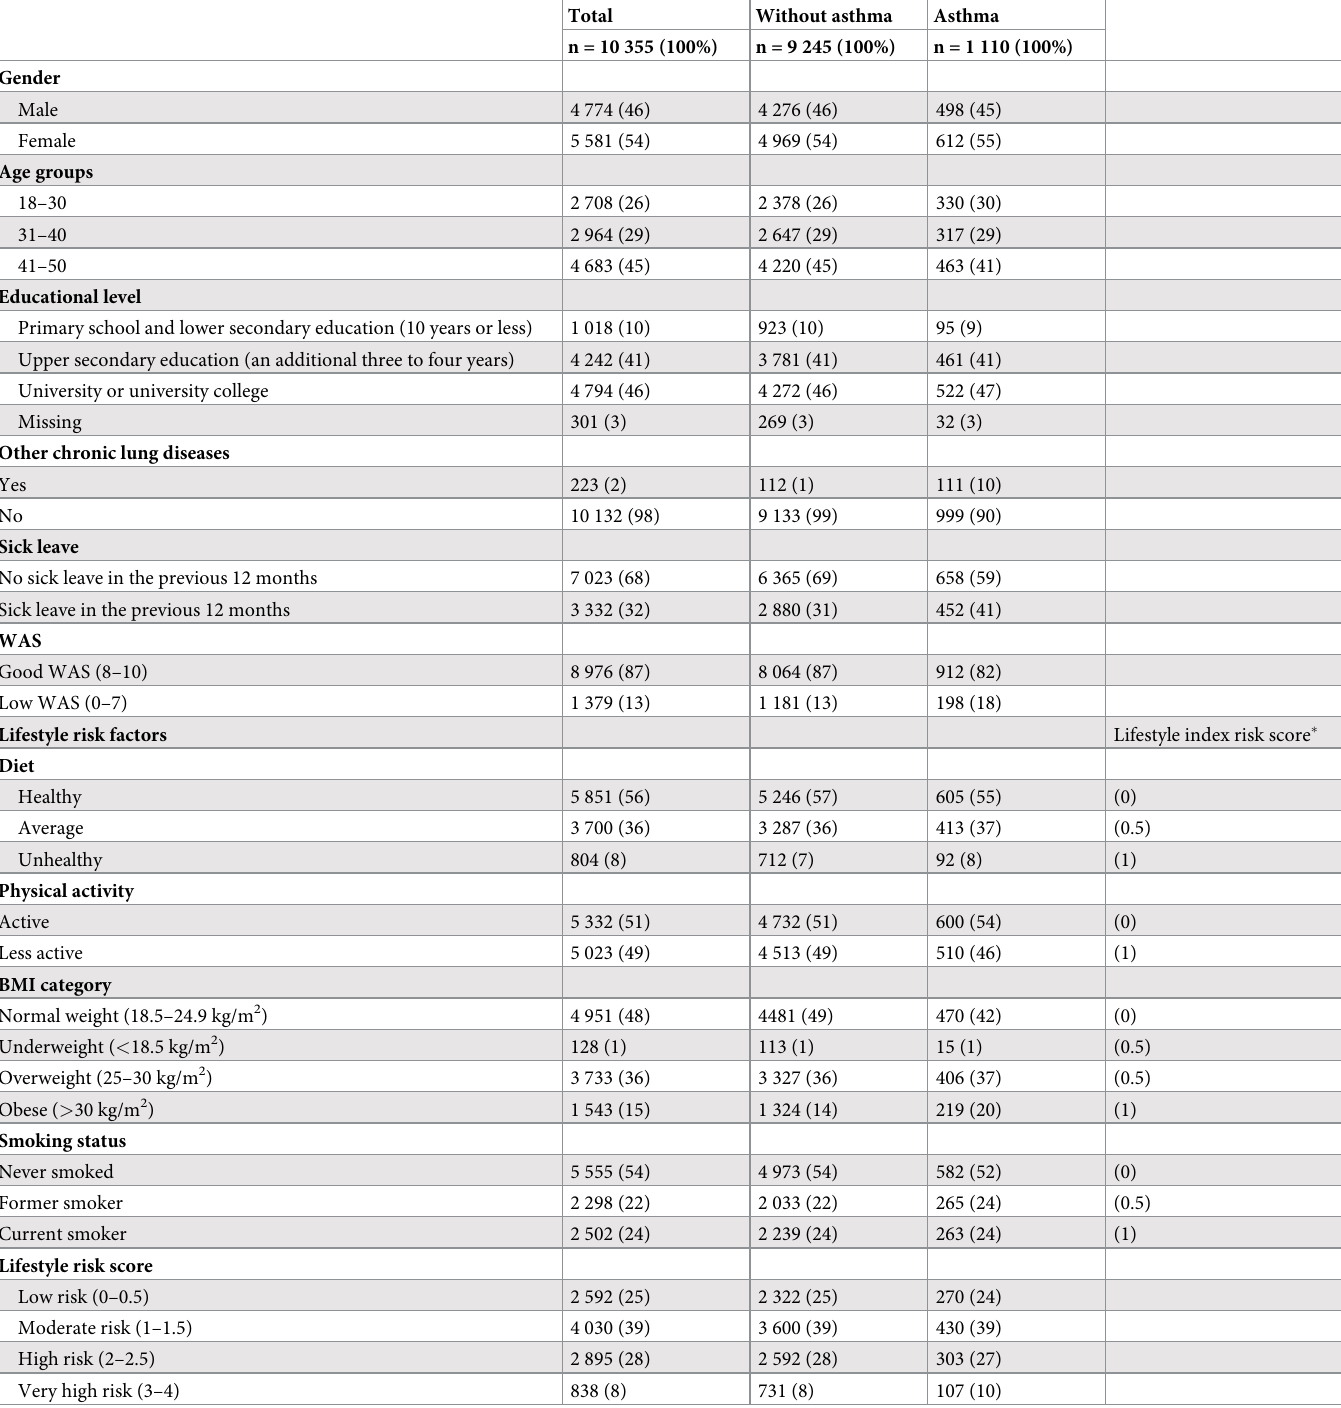
Table 1. Study population characteristics, distribution of main variables and risk